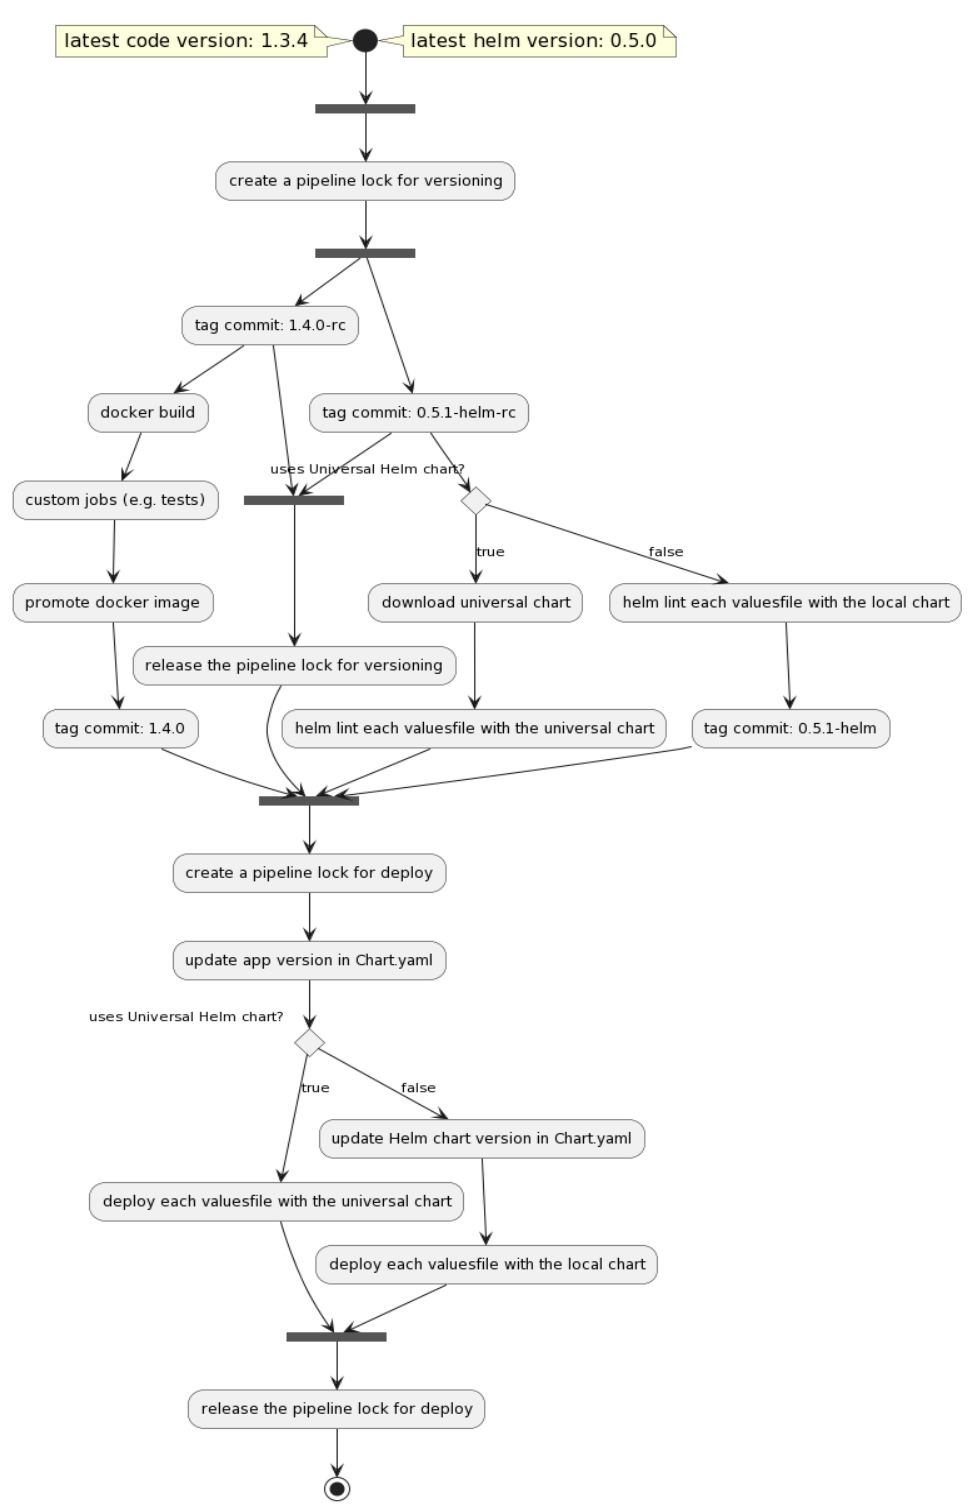
Figure 2. Extended UML Diagram of the proposed solution.